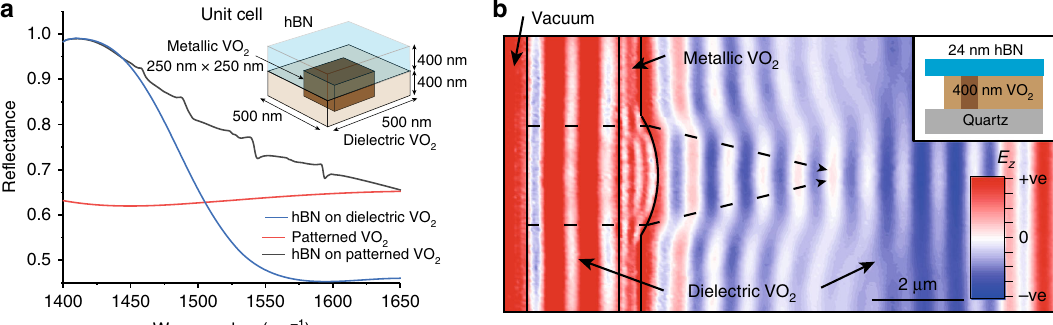
Fig. 4 Schematic of refractive planar optics and recon fi gurable resonators using phase-change materials. a A tunable polariton metasurface of hBN and VO 2 , which consists of a continuous fi lm of hBN 400nm thick on top of 400 nm of VO 2 . By patterning the VO 2 with metallic domains, we can excite a rewritable re fl ection pro fi le, which cannot be generated from either of the materials alone. The pitch is 500 nm, with a particle length 250 nm. b A simulation of a refractive polariton lens, which uses a semi-circular domain of metallic VO 2 to launch polariton waves at 1418 cm − 1